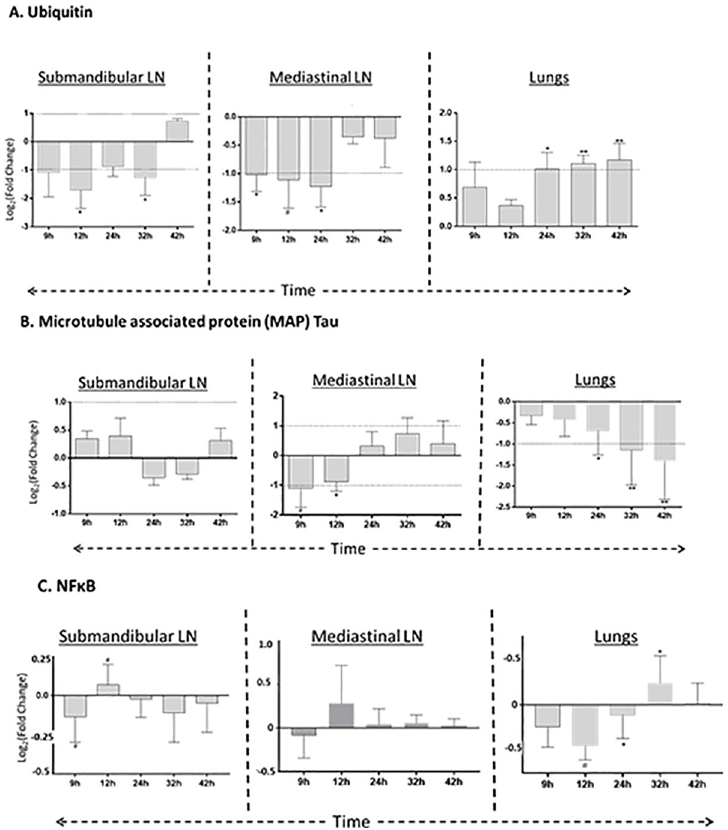
Fig 3. Time and tissue–specific abundance of candidate proteins. (A) Ubiquitin abundance in submandibular LN, Mediastinal LN and Lungs. (B) Microtubule associated protein (MAP) abundance in submandibular LN, Mediastinal LN and Lungs. (C) NF κ B abundance in submandibular LN, Mediastinal LN and Lungs. The dotted line parallel to x- axis depicts the cut-off at fold change ± 1.5. GraphPad Prism was used for visualization and calculation of the statistical significance using Welch’s t -test ( # p < 0.1; � p < 0.05; �� p < 0.01). LN: Lymph